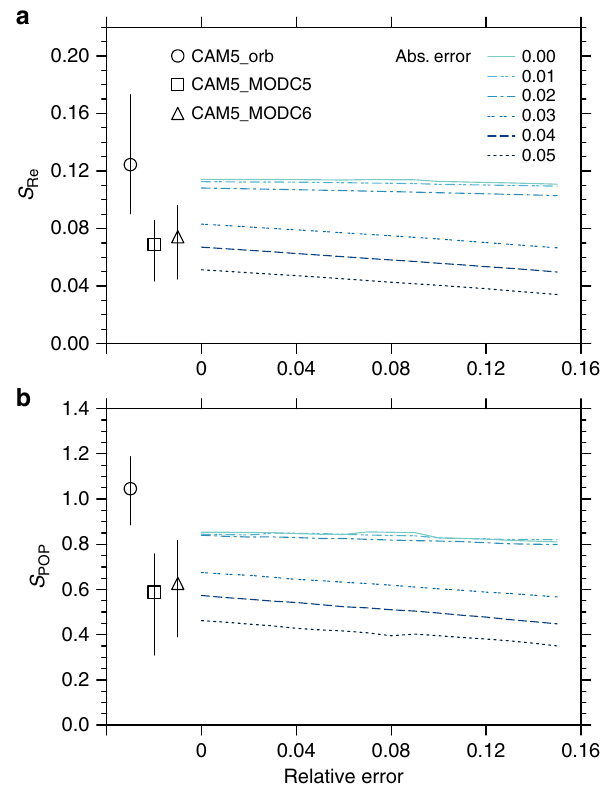
Fig. 4 Model global mean susceptibility of cloud droplet size and susceptibility of precipitation probability when accounting for the retrieval uncertainty. Susceptibilities S Re ( a ) and S POP ( b ) are evaluated when the MODIS AOD retrieval uncertainty is imposed. The MODIS AOD retrieval uncertainty, expressed as expected error (EE = ± ( a + r ⋅ AOD), where a is the absolute error and r is the relative error), is imposed on CAM5_orb in the form of random noise with a normal distribution with the standard deviation of EE. Colored lines represent S Re and S POP as a function of absolute and relative errors imposed on the CAM5_cld results. The CAM5_orb, CAM5_orb with MODIS Collection 5 EE (CAM5_MODC5), and CAM5_orb with MODIS Collection 6 EE (CAM5_MODC6) are depicted by circle, square, and triangle, with vertical bars denoting the range of S Re and − 2 . The difference of S S POP for a range of LWP from 20 to 200 g m Re and S POP between CAM5_orb and the estimates with zero errors is caused by the cloud clearing procedure. The MODIS Collection 5 EE is ± (0.05 + 0.15 · AOD) over land and ± (0.03 + 0.05 · AOD) over ocean 35 . The MODIS Collection 6 EE is ± (0.05 + 0.15 · AOD) over land and + (0.04 + 0.10 · AOD) and − (0.02 + 0.10 · AOD) over ocean 36 . Due to the asymmetry of the MODIS Collection 6 EE over ocean, two normal distributions (with the standard deviation of 0.04 + 0.10 · AOD and 0.02 + 0.10 · AOD, respectively) are produced. The positive part of the fi rst distribution and the negative part of second distribution are used to represent the full MODIS Collection 6 EE and are superimposed on the CAM5_cld